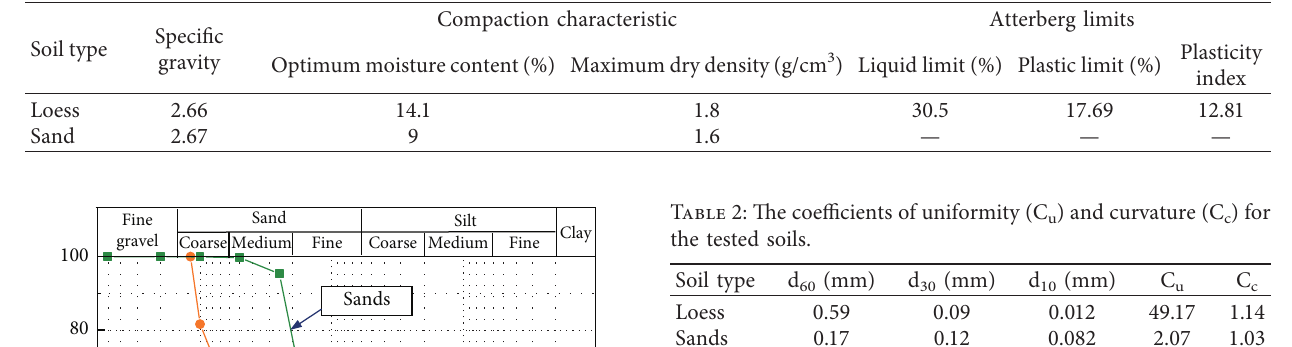
Table 1: Physical properties of the test soils.